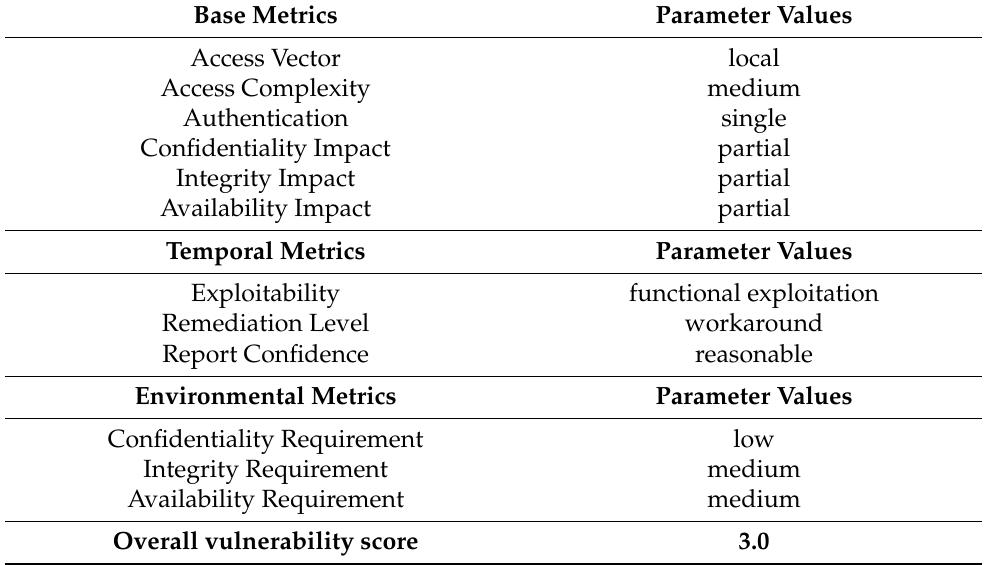
Table 3. Summary of the vulnerability analysis for the EV-EVSE sub-systems communication. The parameter values indicate our choice to the different metrics of the CVSS